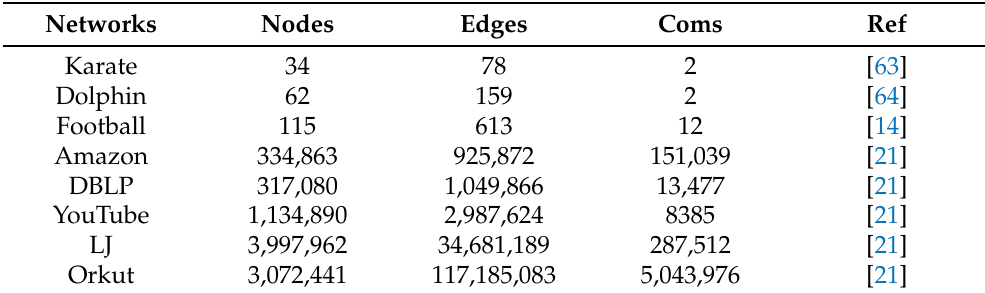
Table 3. The information of real networks. The columns “Nodes”, “Edges” and “Coms“ report the numbers of nodes, edges and ground-truth communities, respectively, and the “Ref” reports the references of these networks.